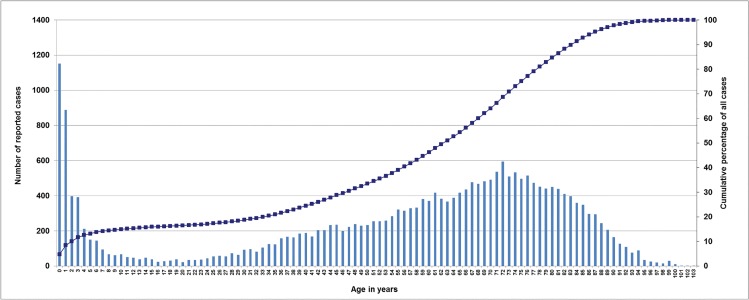
Age distribution of reported IPD isolates (1992–2014) in Germany (n = 24,235).Left y-axis: number of reported cases, right y-axis cumulative percentage of all cases. Data represent the age distribution of isolates sent to the GNRCS on a voluntary basis. Since the surveillance system was improved several times (see materials and methods section), the graph does not necessarily represent the actual prevalence of IPD in the different age groups in Germany.